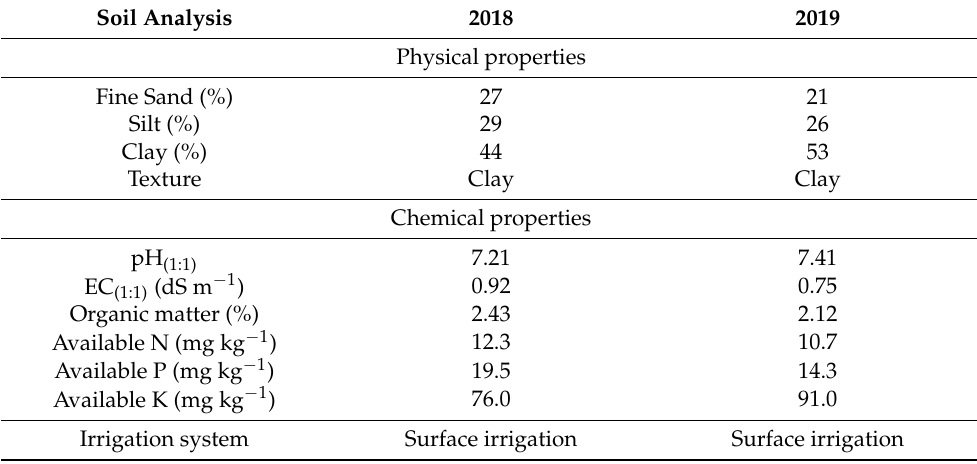
Table 2. Soil properties at the experimental site in 2018 and 2019 seasons.